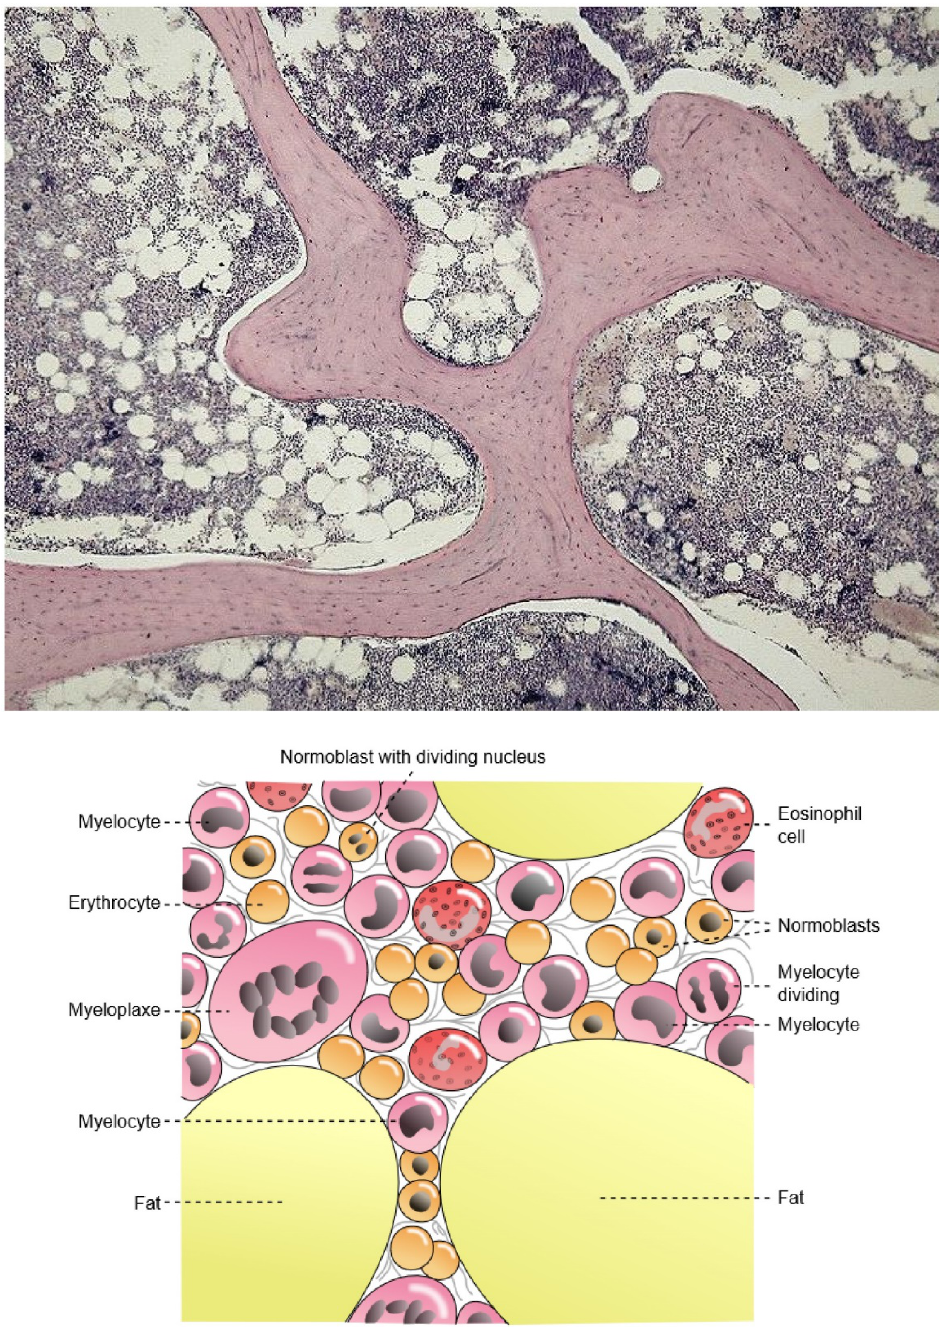
Figure 1. A (upper figure): Unprocessed bone is filled with marrow that blocks the access to deeper layers of the available matrix surface. From: https://en.wikipedia.org/wiki/File:Spongy_bone_-_trabecules.jpg#filelinks Courtesy: Department of Histology, Jagiellonian University Medical College. B (lower figure): Bone marrow is containing immunogeneic cells and fat, eliciting undesired inflammatory reactions . Eventual pathogens may be present exclusively in the marrow, and not inside the bony matrix. From: